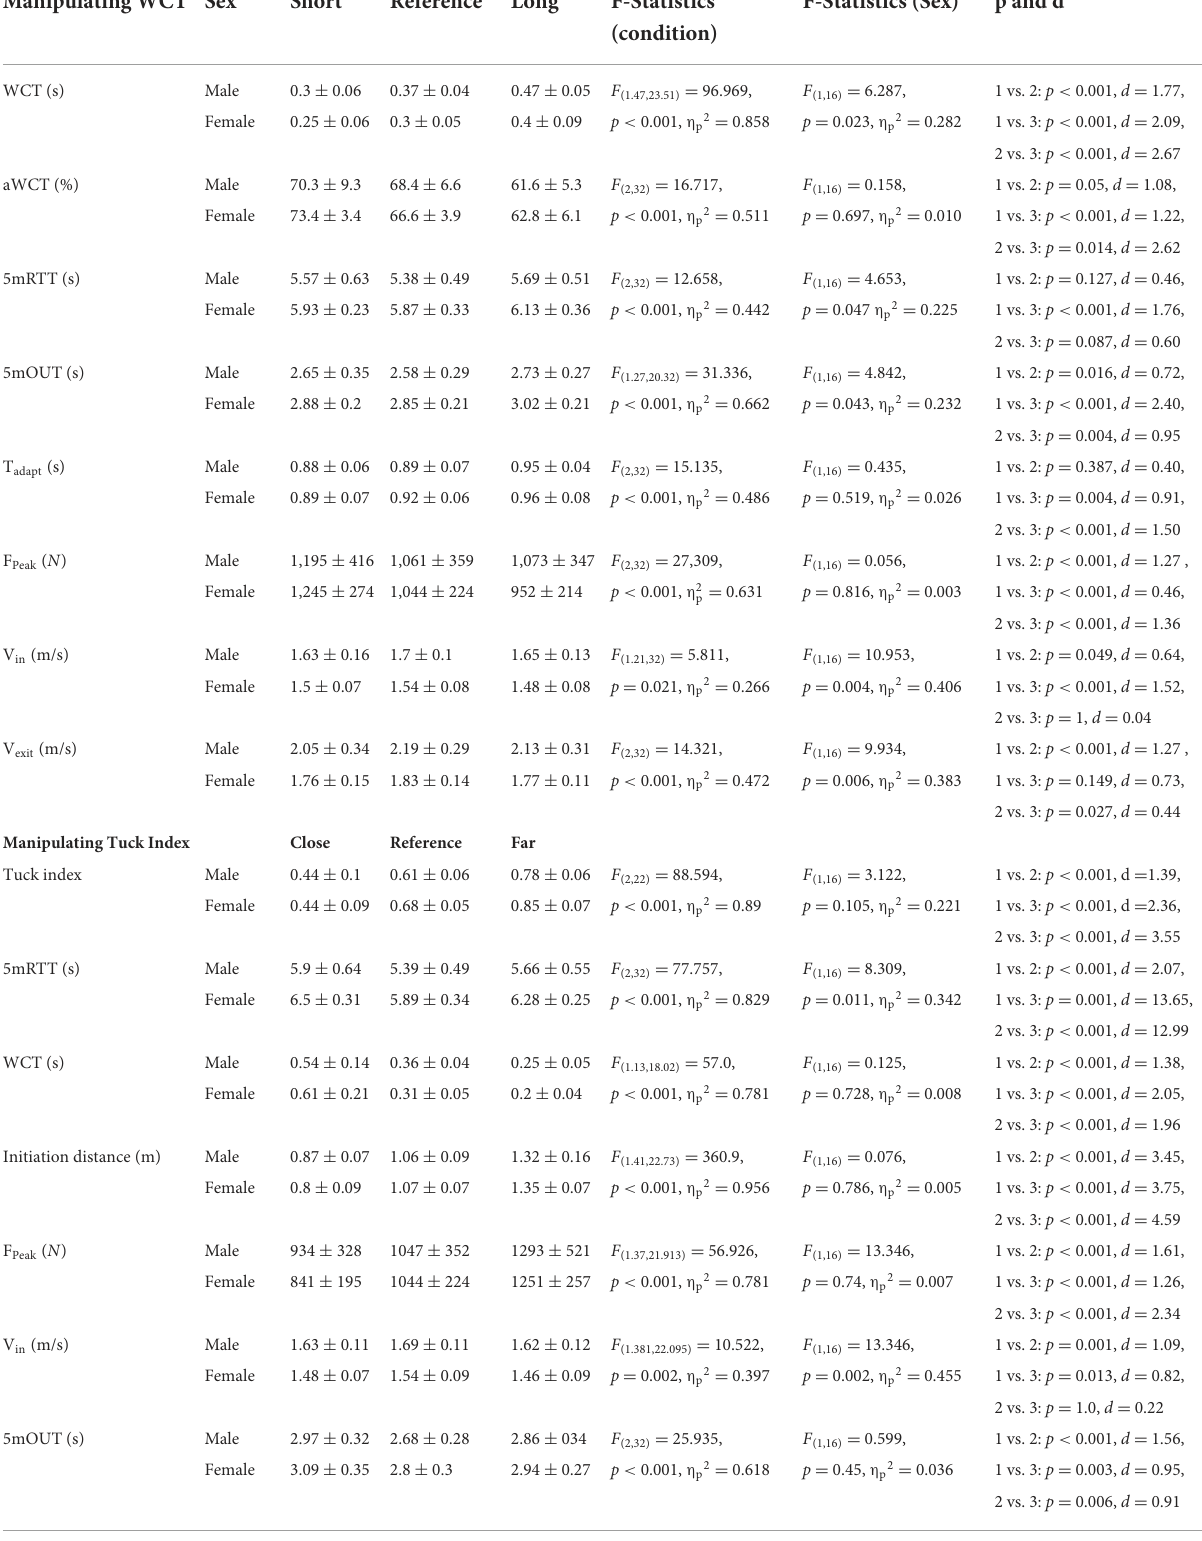
TABLE 3 Descriptive (mean ± standard deviation) and statistical results of the 2 × 3 repeated measures ANOVA design with the manipulation condition as the within-subject factor (main effect) and sex as the between-subject factor (interaction effect). Manipulating WCT Sex Short Reference Long F-Statistics F-Statistics (Sex) p and (condition)